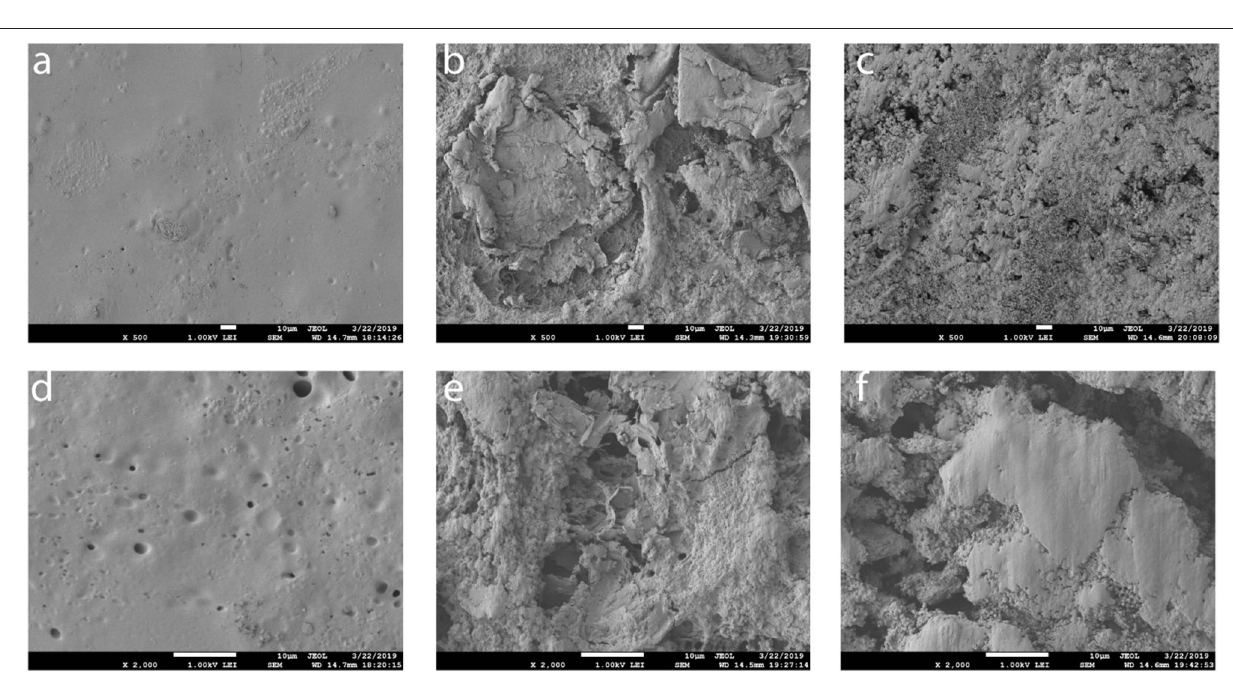
pH Values of Feed and Product